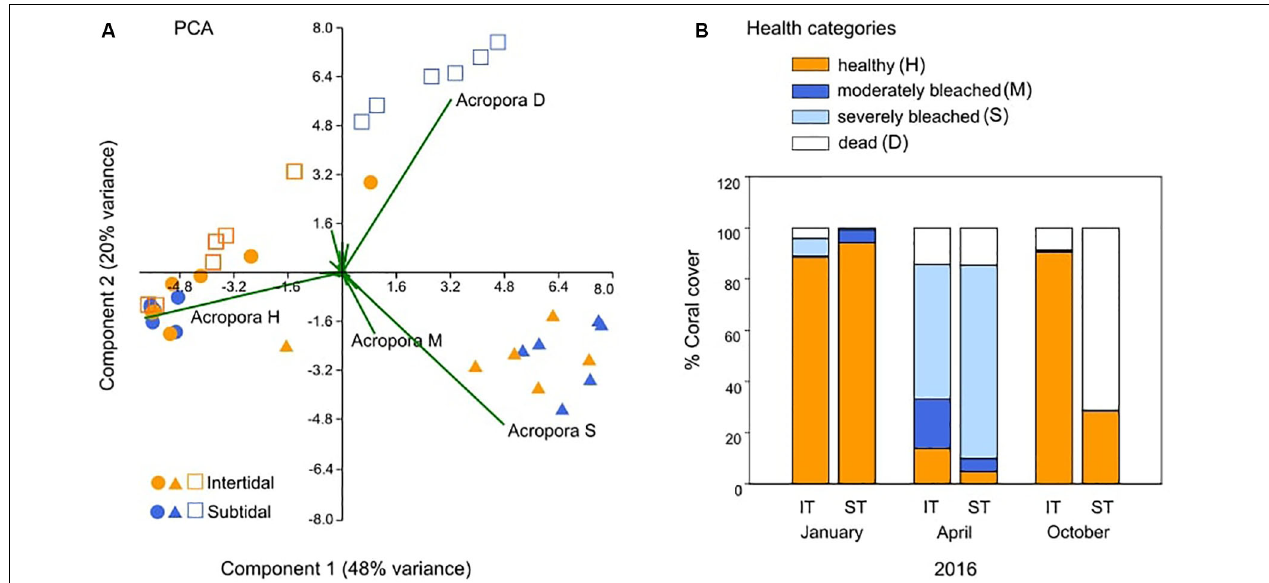
FIGURE 2 | Changes in reef-wide coral health over time based on coral health surveys. (A) Principal components analysis (PCA) of coral health across all hard coral genera in the intertidal (IT) and subtidal (ST) before (January, • ), during (April, (cid:78) ), and 6 months after (October, (cid:3) ) a bleaching event in 2016. Vectors represent the dominant coral genus Acropora and its associated health status (see below) because it had the greatest influence on overall coral health. (B) Percent coral cover that was healthy (H), moderately bleached (M), severely bleached (S), or dead (D) at the same time points. Data for January and April 2016 are also included in Le Nohaïc et al. (2017).